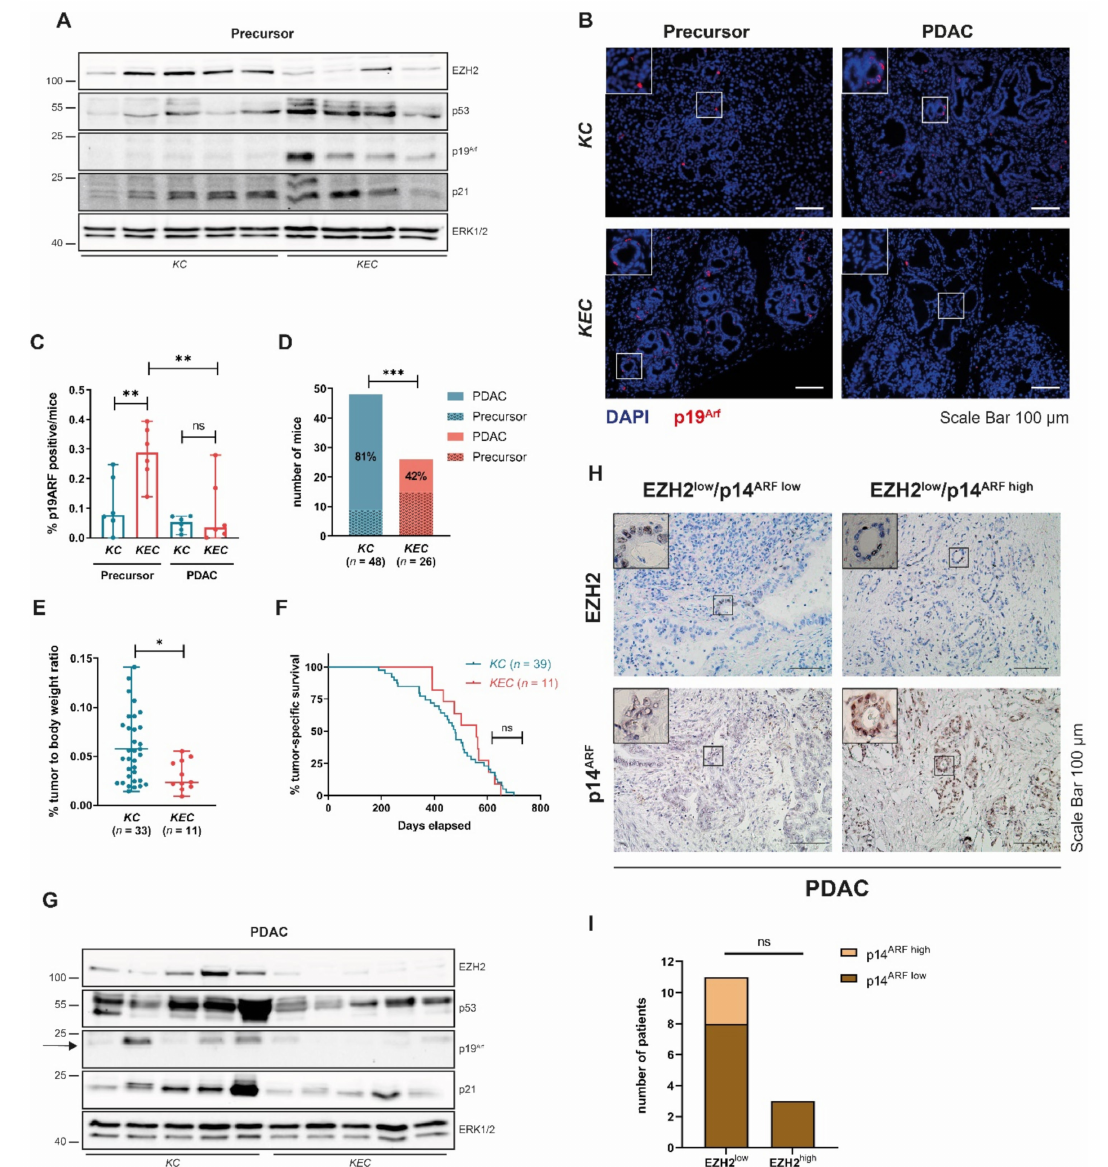
Figure 6. EZH2-independent p19 Arf regulation in vivo . ( A ) Western blot analysis with pancreatic lysates derived from 8-week-old KC and KEC mice carrying PDAC precursor lesions. ( B ) Represen- tative images of immunofluorescence staining of p19 Arf in precursor (12 week) and PDAC of KC and KEC mice. Scale bar, 100 µ m. ( C ) Quantification of p19 Arf staining. Counting was performed in six representative images of six different mice per condition using ImageJ Fiji. One dot represents one mouse. Significance was determined using two-tailed unpaired Student’s t -test, *, p ≤ 0.05; **, p ≤ 0.01, ns, non-significant. ( D , E ) Bar graph showing tumor incidence (significance was deter- mined using Fisher’s exact test, ***, p ≤ 0.001) ( D ) and relative body weight (each dot represents one mouse, significance was determined using two-tailed unpaired Student’s t -test, *, p ≤ 0.05) ( E ). ( F ) Kaplan–Meier plot of KC and KEC mice to illustrate tumor-specific survival. Significance was determined by log-rank (Mantel–Cox) test. ns, non-significant. ( G ) Western blot analysis from PDAC lysates derived from KC and KEC mice. Arrow indicates an unspecific band. ( H ) Representative im- ages of EZH2 and p14 ARF immunohistochemistry of human PDAC grouped in EZH2 low /p14 ARF low and EZH2 low /p14 ARF high . Scale bar, 100 µ m. ( I ) Bar graph showing quantification of p14 ARF positive cells in human PDAC ( H ). Significance was determined using two-tailed unpaired Student’s t -test, ns,